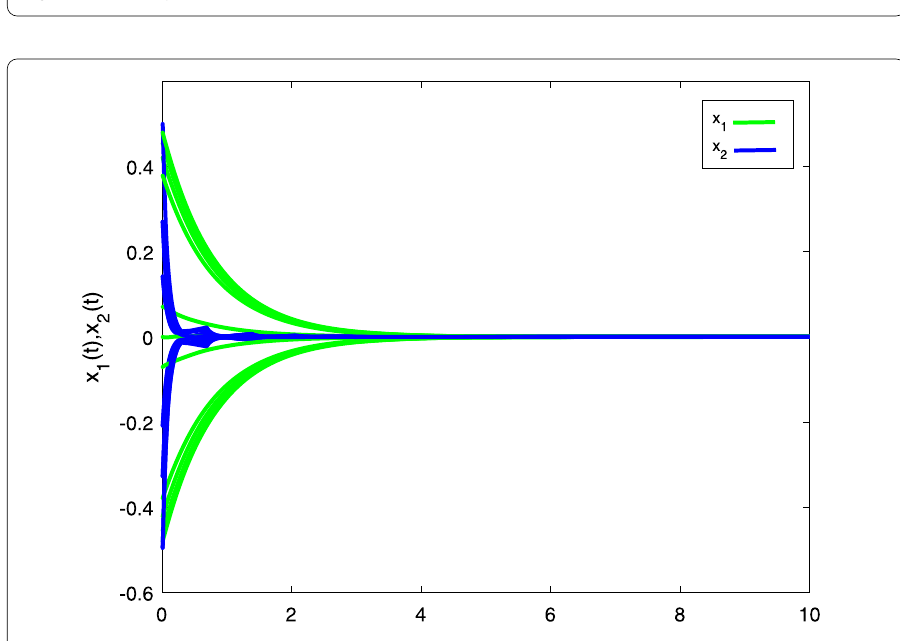
Figure 1 State trajectories for neural networks (5) without control input